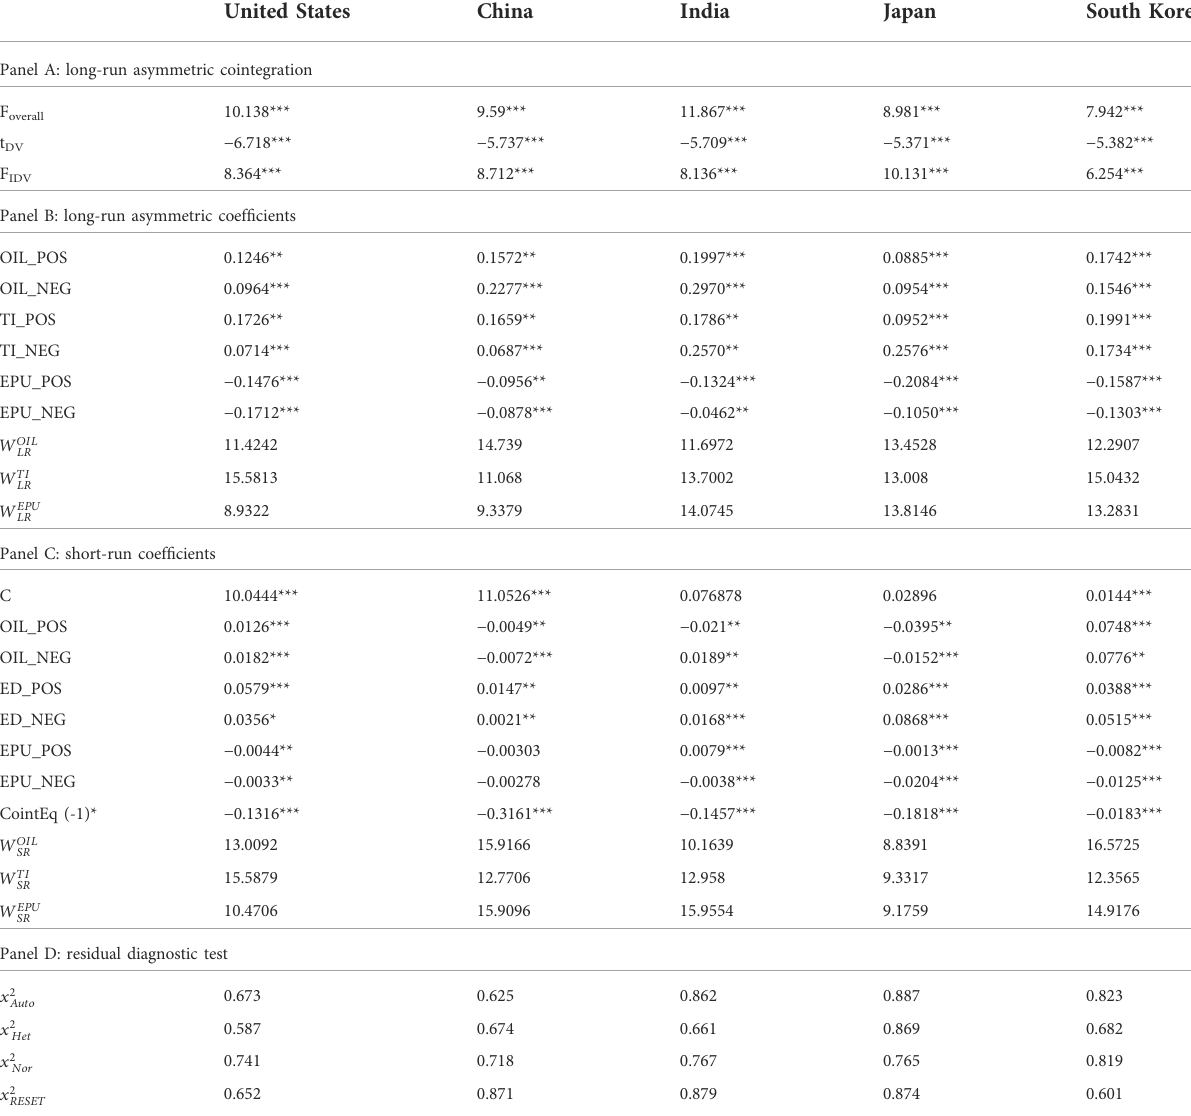
TABLE 6 Results of asymmetric effects of oil price, technological innovation, and economic policy uncertainty. United